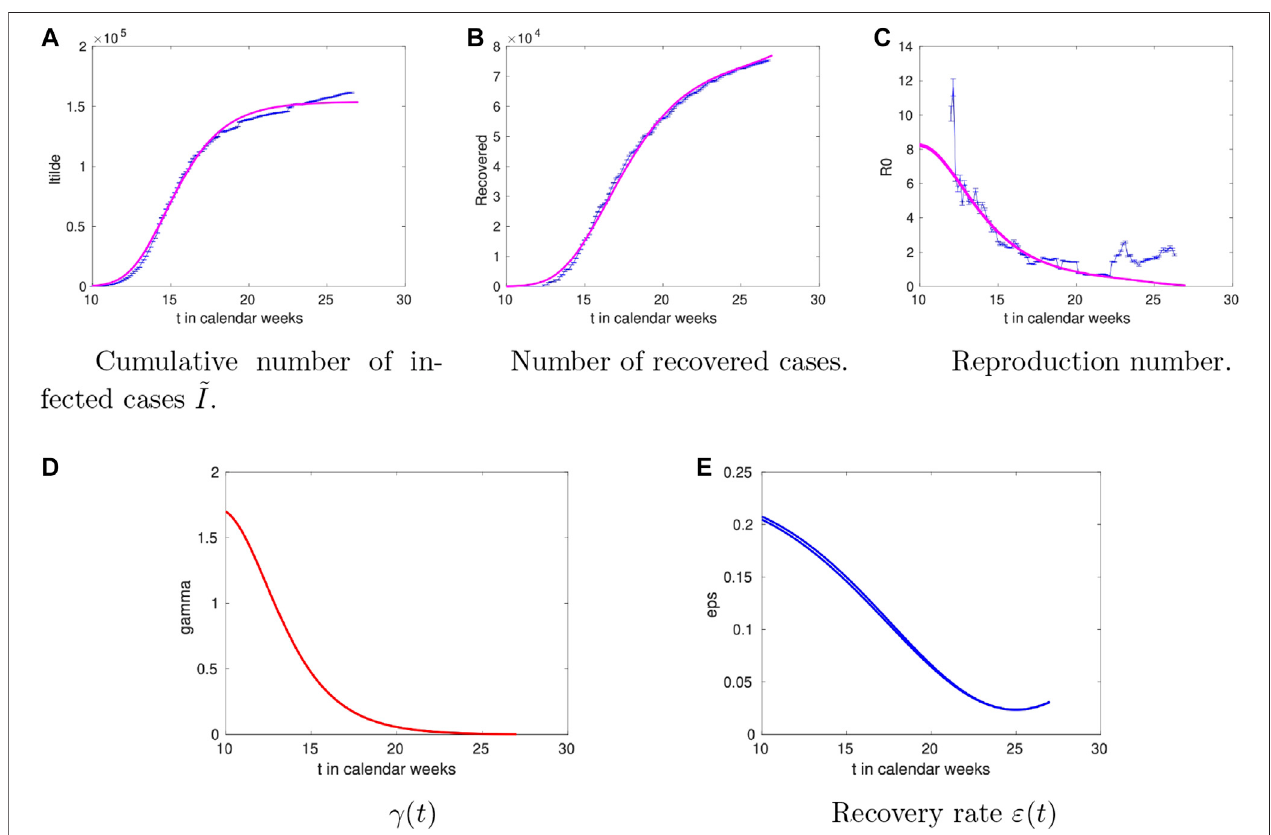
FIGURE 5 | Time dependence of ~ I ( t ) , R ( t ) , R 0 ( t ) , c ( t ) and ε ( t ) within the eRG SIR model optimised to describe the French data for COVID-19. Solid lines are the model (shown as a 95% con fi dence level band for the predictions) and the dots with error-bars are the data.